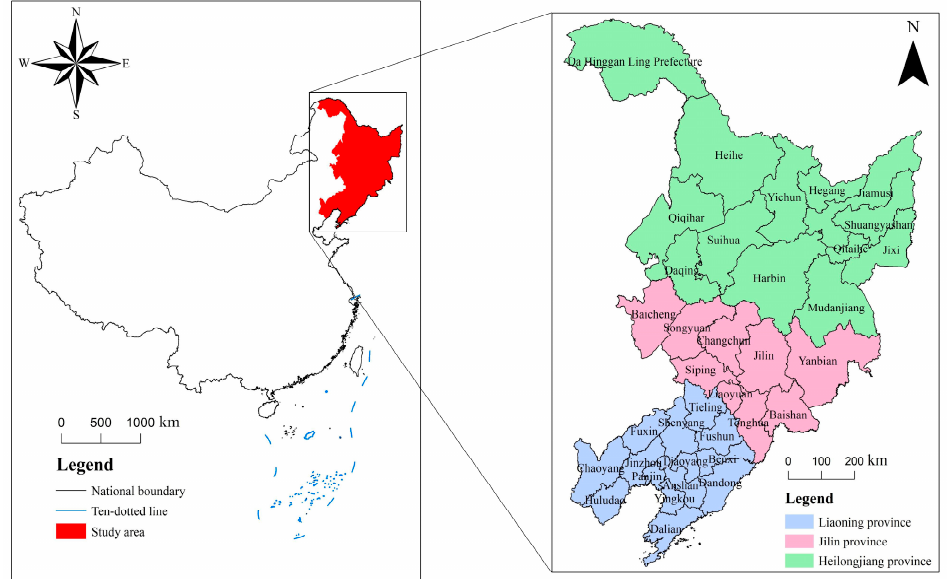
Figure 2. Geographical location of the three northeastern provinces of China. Note: The figure number is GS(2019)1822.